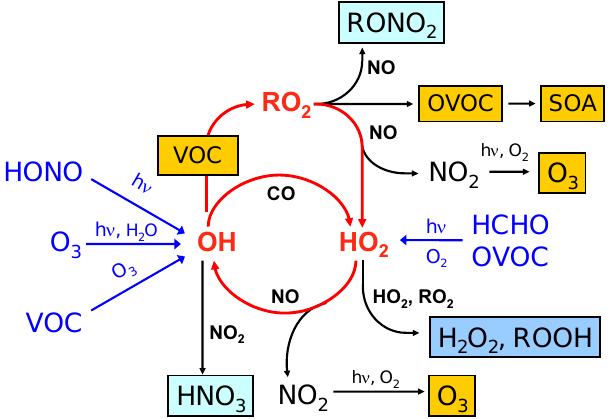
Fig. 1. Schematic drawing of HO x chemistry, illustrating estab- lished, major chemical pathways in the troposphere. Radical chem- istry is initiated by primary radical production (blue arrows) through photodissociation and ozonolysis reactions and is terminated by radical recombination reactions forming nitric acid (HNO 3 ), hy- droperoxides (H 2 O 2 , ROOH) and organic nitrates (RONO 2 ). Radi- cal chain reactions (red arrows) cause cycling between OH, HO 2 , and RO 2 . Reactions of RO 2 and HO 2 with NO reproduce OH (secondary OH production) and lead to photochemical formation of ozone, OVOCs and